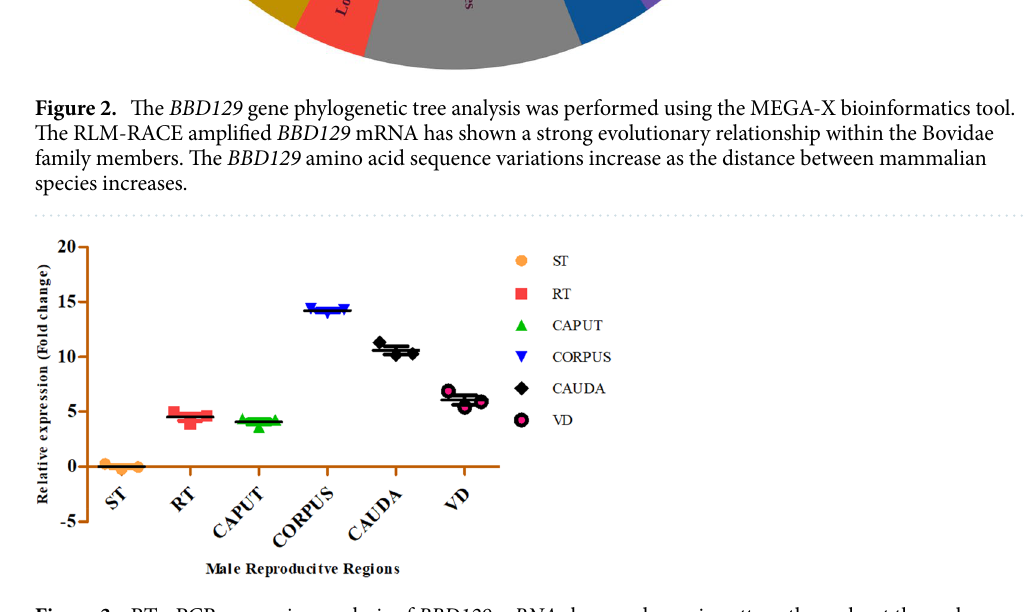
Figure 3. RT-qPCR expression analysis of BBD129 mRNA shows a dynamic pattern throughout the male reproductive tract. About 14 folds of BBD129 mRNA were observed in the corpus-epididymis region compared to the normalizer region, viz. seminiferous tubule (ST). The lowest expression (~ 4 folds) of BBD129 mRNA was observed in the caput-epididymis